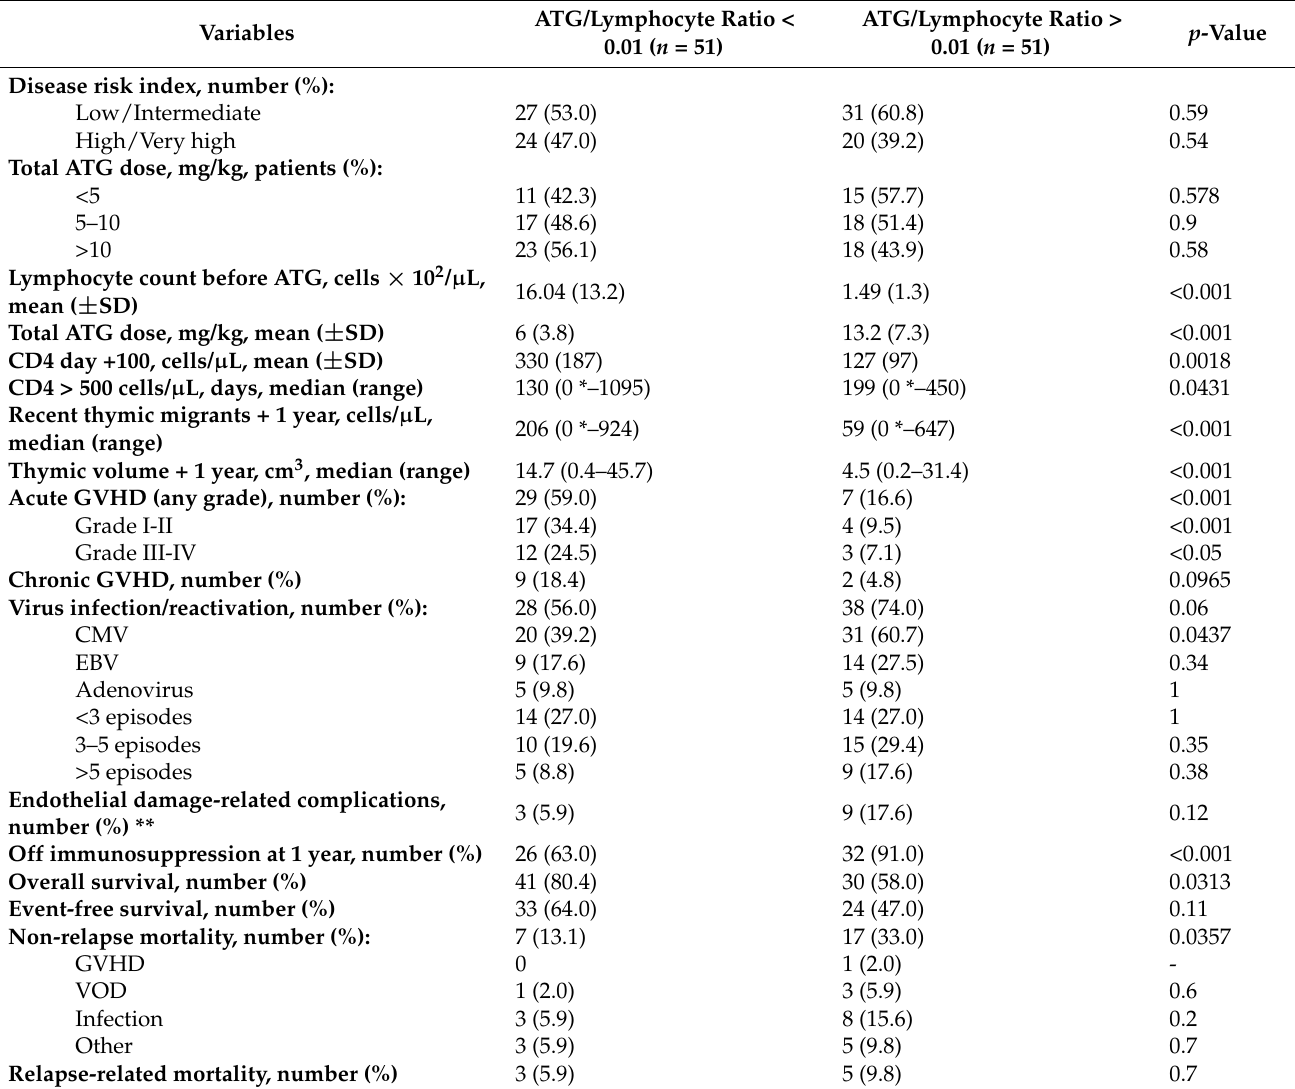
Table 2. Comparison of transplant outcomes between low ATG/lymphocyte ratio group and high ATG/lymphocyte ratio